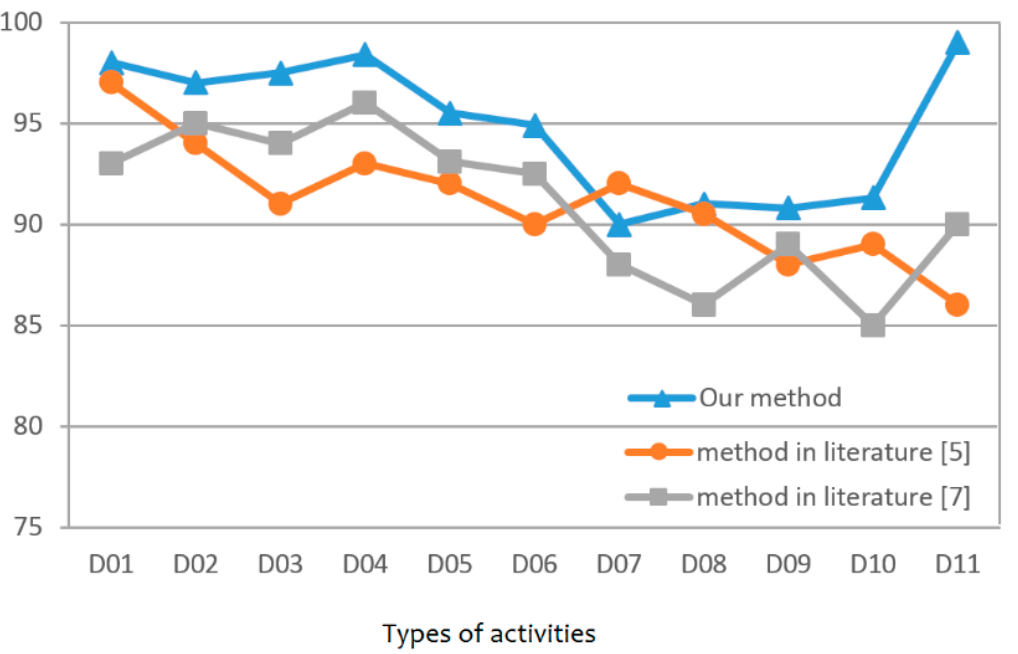
Table 3. Feature values of different motions.